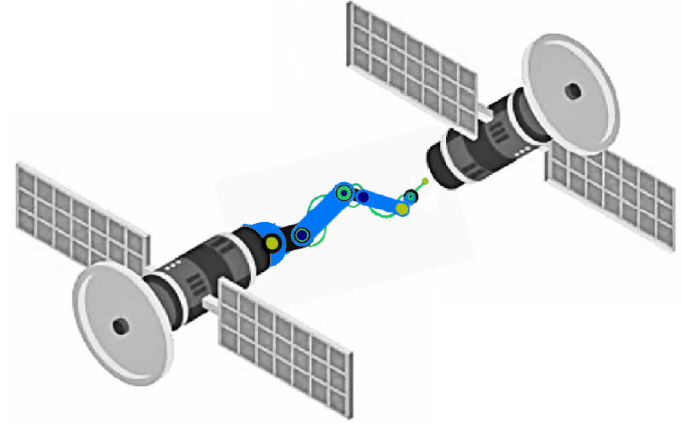
Figure 1. Concept image of a robotic arm for on-orbit service. The robotic arm is used to assist in the combination of the two satellites.